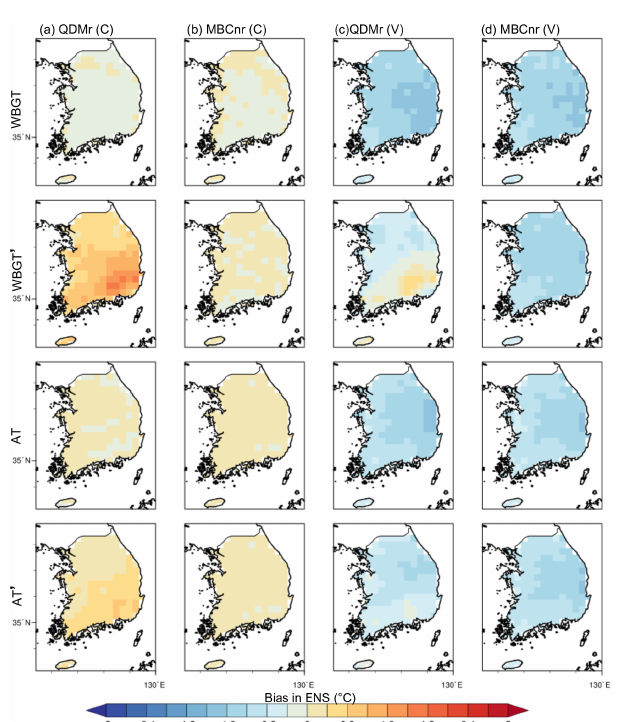
Figure 6. Spatial maps of the bias in the 90p during the calibration period (C) and validation (V) period corrected by QDM and MBCn in ENS. The first and third rows are the directly corrected WBGT and AT. The second and fourth rows are the WBGT (cid:48) and AT (cid:48) calcu- lated by the corrected T and RH.